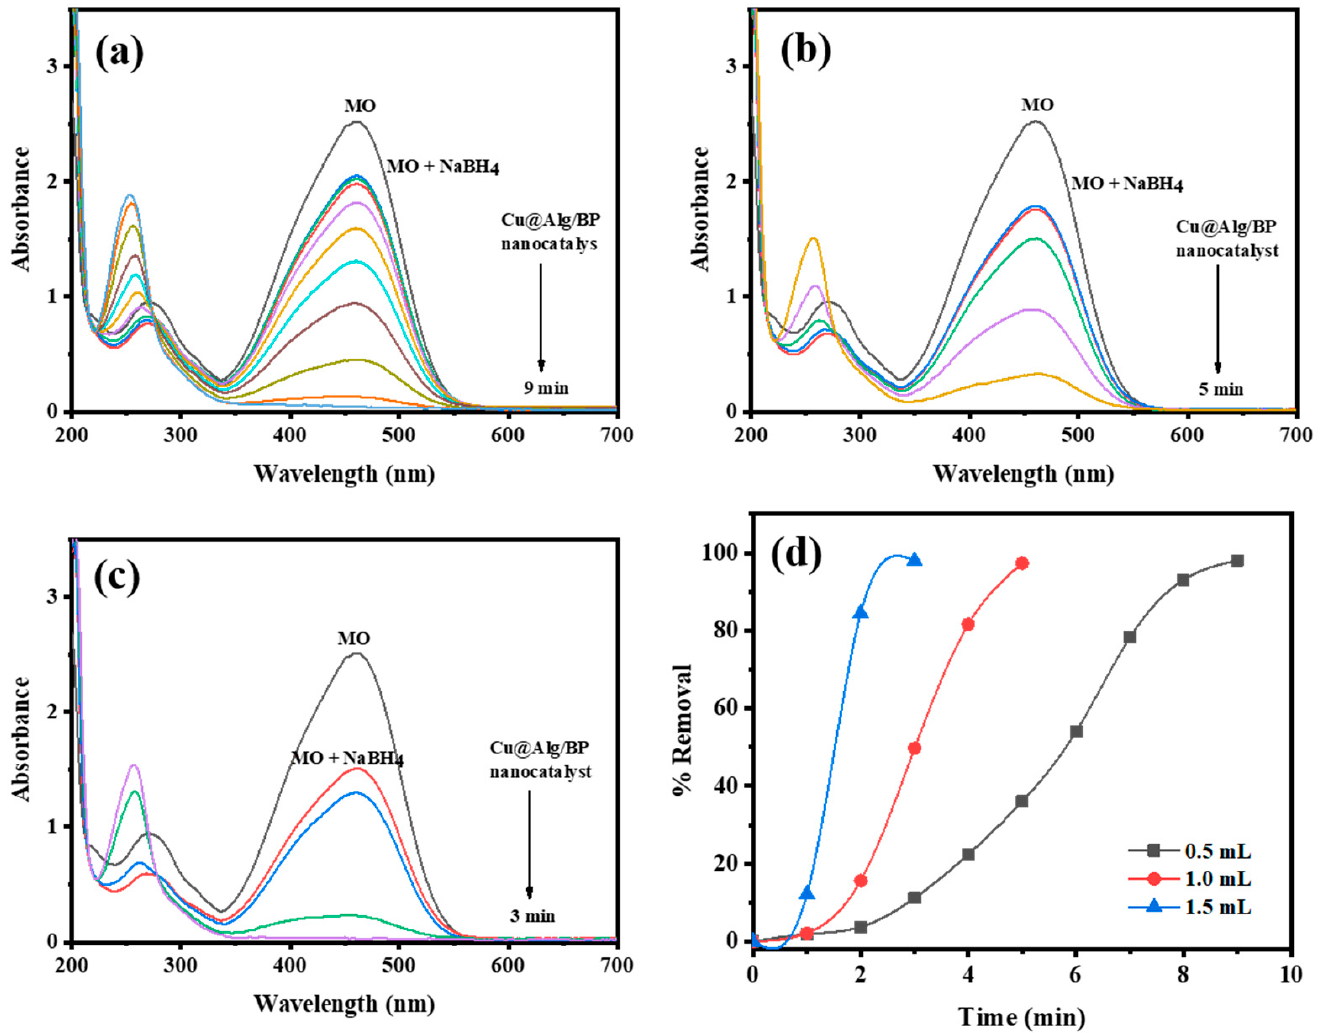
Figure 8. Time-dependent UV–Vis spectra for reduction of MO by different concentrations of NaBH 4 ( a ) 0.5 mL; ( b ) 1.0 mL; and ( c ) 1.5 mL using 3 beads of Cu@Alg/BP nanocatalyst. ( d ) Removal % of MO in presence of Cu@Alg/BP.